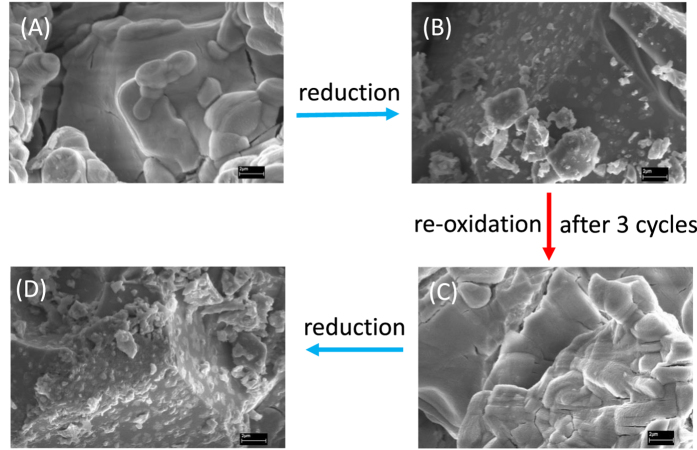
SEM pictures of sample SrFe0.8Cu0.1Nb0.1O3−δ powders after obtained in air (A); after further reduction in 5%H2/Ar at 700 °C for 10 hours (B); after further xoidise in air at 1300 °C for 15 hours then reduce at 700 °C in 5%H2/Ar for 10 hours (3 cycles with final step of reoxidation) (C) and futher reduction in 5%H2/Ar at 700 °C for 10 hours (D).